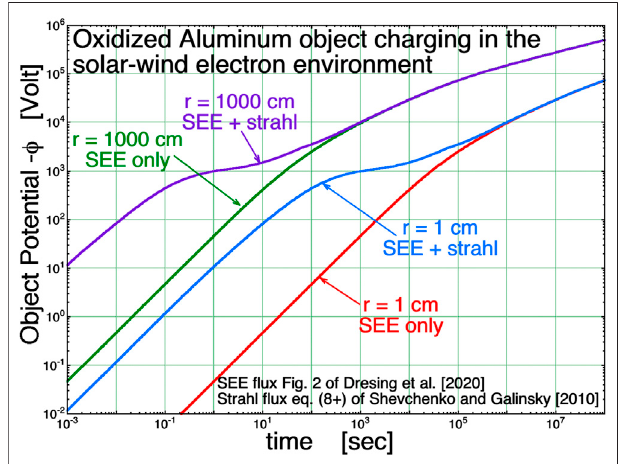
FIGURE 4 | Rudimentary charging calculations for spherical objects in a bath of energetic electrons using a measured distribution of solar energetic electrons at 1